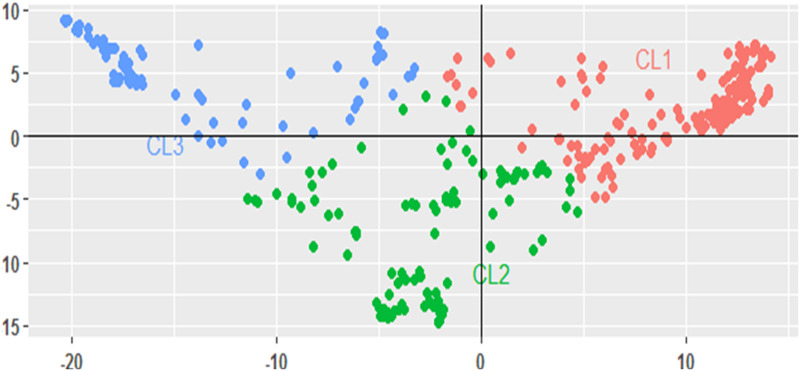
A bi-plot of the first two principal components (PC1 and PC2) of 357 cowpea genotypes, using 6 498 SNP markers.Each color corresponds to population structuring and grouping.